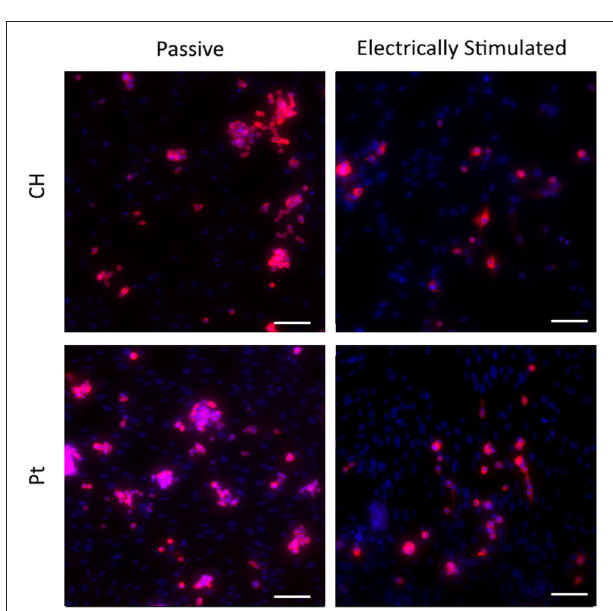
FIGURE 10 | Magnified immunofluorescence images of PC12 and OEC co-cultures on passive and electrically stimulated Pt and CH substrates (200 × magnification). Nuclei of both cell types were stained with Hoechst 33,342 (blue) and PC12 only cell bodies and neurites stained with anti- β III-tubulin (red). Scale bars = 150 µ